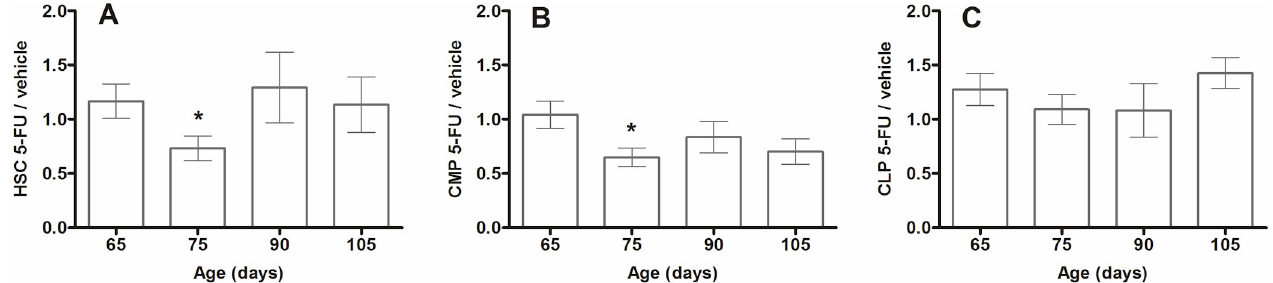
Fig 2. Circulating hematopoietic stem cells in SOD1G93A mice after fortnightly 5-FU administration. Data is shown as the mean fold change +/- SEM in the percentage of (A) HSC, (B) CMP and (C) CLP in 5-FU treated SOD1G93A mice compared with the mean of vehicle-treated SOD1G93A mice (n = 10 per group). Day 65 are the pre-treatment samples and days 75, 90 and 105 are each taken after 4 days from last 5-FU administration. � p <